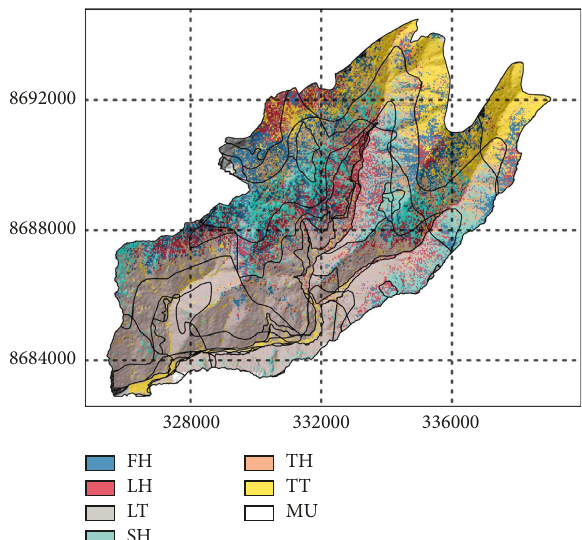
Figure 4: Spatial distribution of soil classes at the subgroup level in soil taxonomy. The black lines represent the boundaries of homogeneous land units (MU).